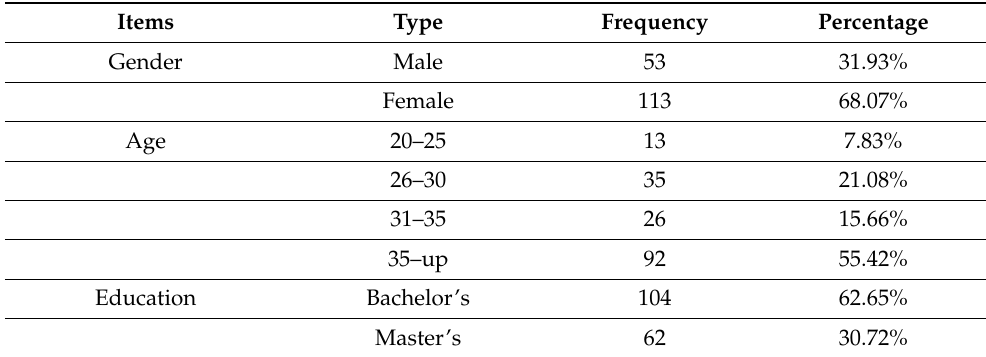
Table 2. Descriptive statistics of junior high school teacher